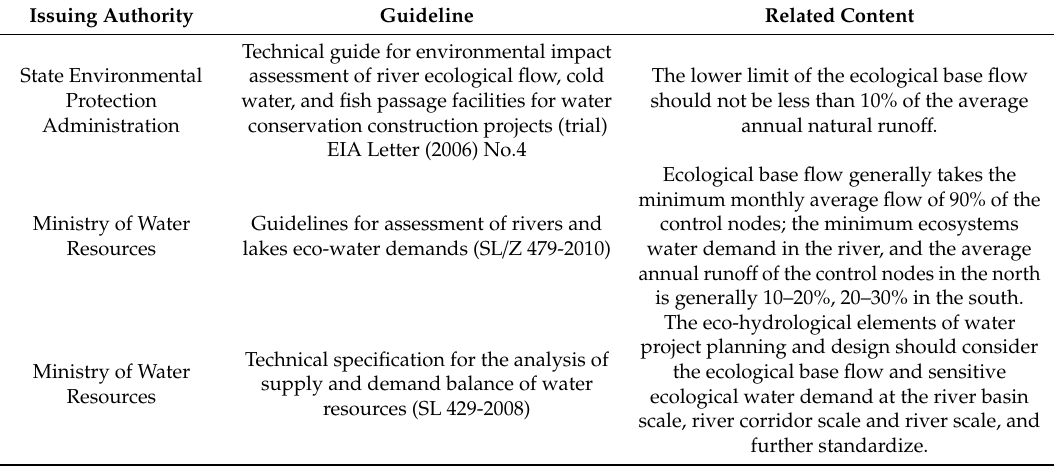
Table 1. Typical guidelines for environmental flows issued by Chinese